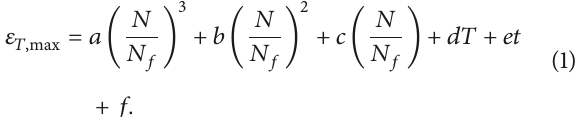
Table 4: Test data of fatigue for